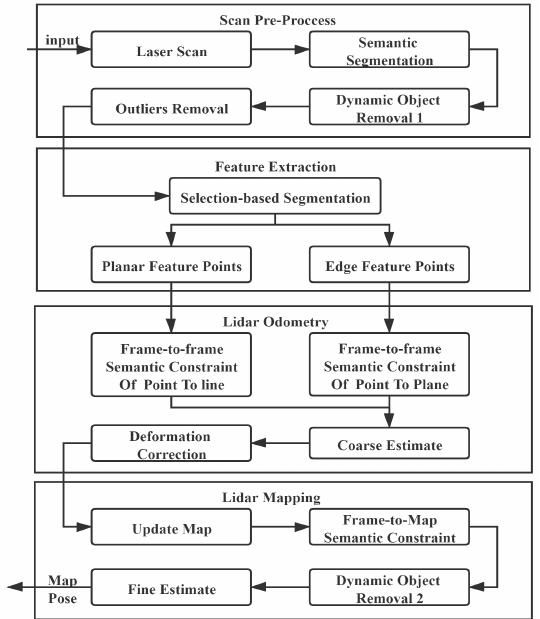
Figure 1. An overview of the proposed LiDAR localization and mapping